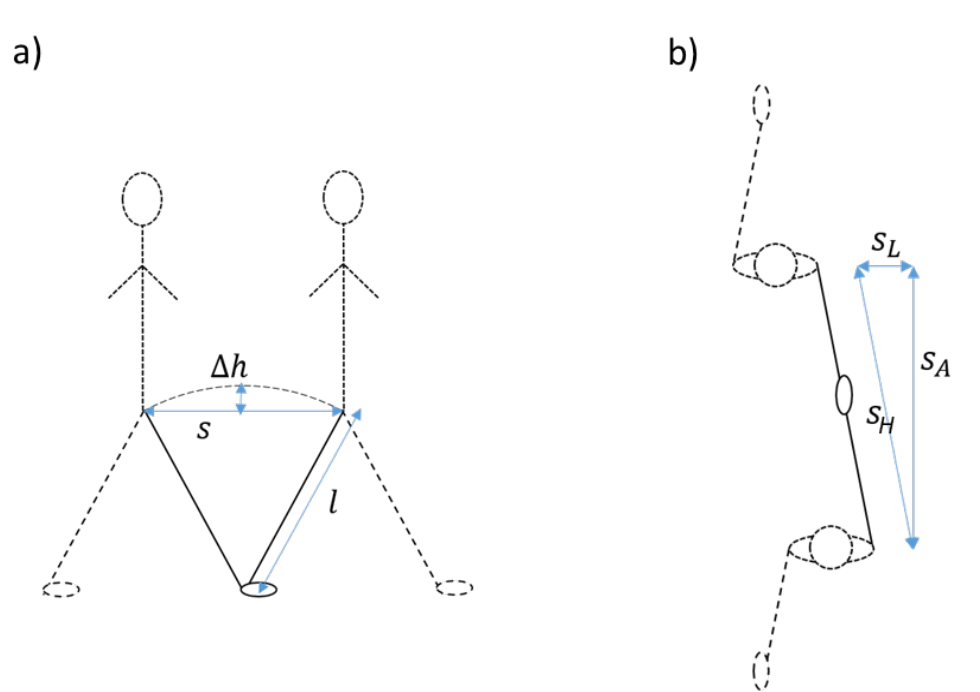
Figure 2. Explanation of the inverted pendulum model (( a ), side view) and of the addition of lateral movement in our updated version of the algorithm (( b ), top view).